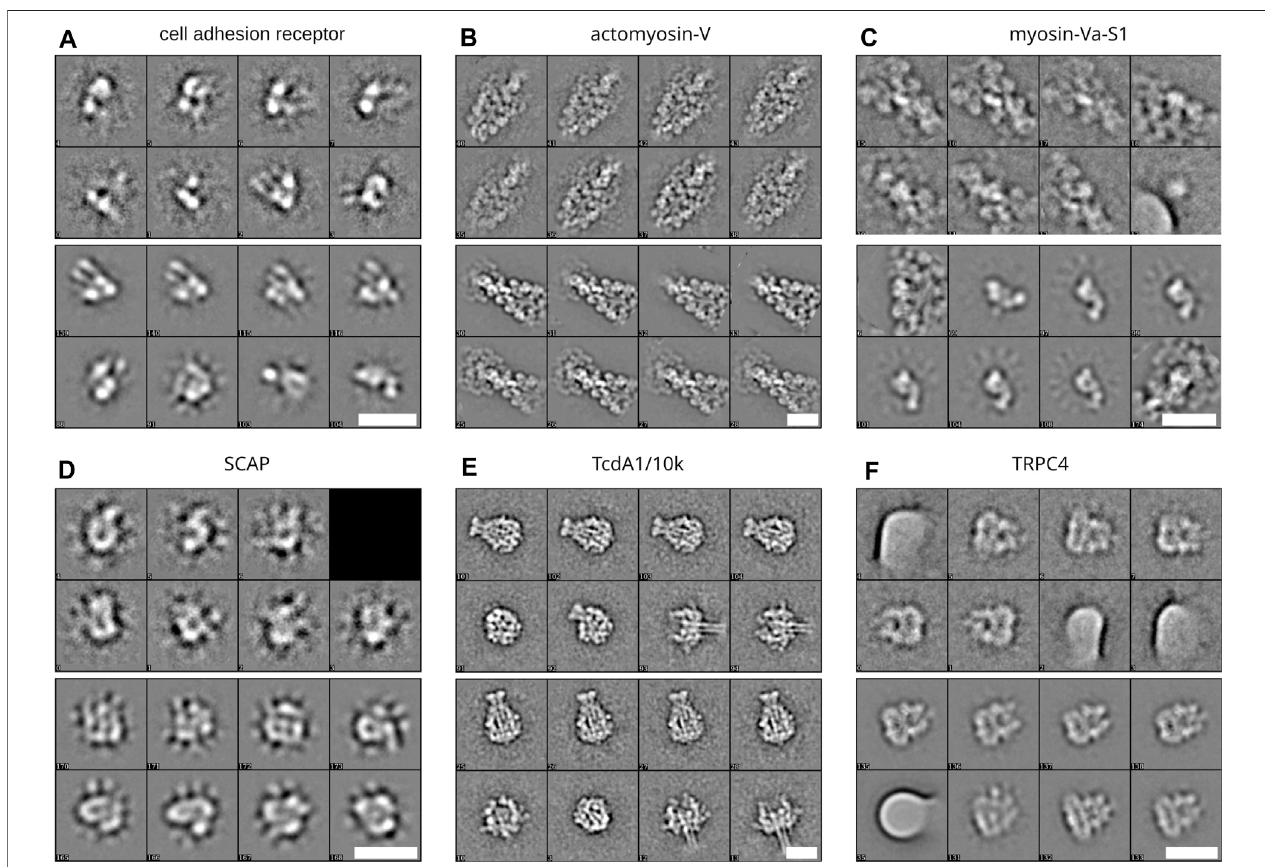
FIGURE4| Classaveragesfromdifferentdatasets.Averagesproduced when processing thedifferent datasets in Figure 3(A – F) Each section depicts ablockof eightrepresentativeaverageswhenprocessing10,000particles(topeightaverages)and200,000particles(lowereightaverages)ofcelladhesionreceptor,actomyosin- V, myosin, SCAP, TcdA1/10k, and TRPC4, respectively. Scale bars, 20